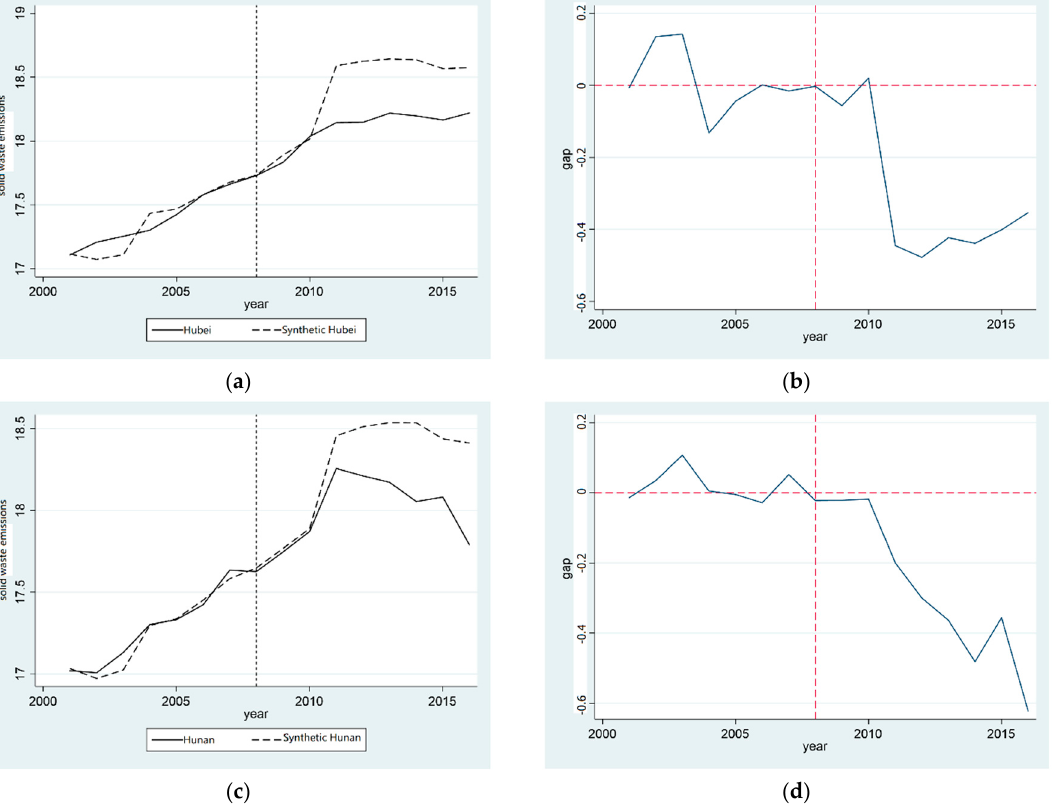
Figure 3. Comparison of reduction effect of total emissions of general industrial solid waste in provinces established in the pilot zone of “two-oriented society”. ( a ) Comparison of solid reduction in Hubei; ( b ) Gap in solid reduction in Hubei; ( c ) Comparison of solid reduction in Hunan; ( d ) Gap in solid reduction in Hunan